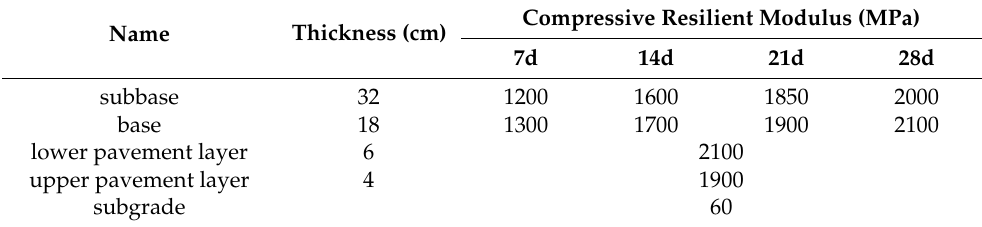
Table 6. Calculation parameters of structural layers.